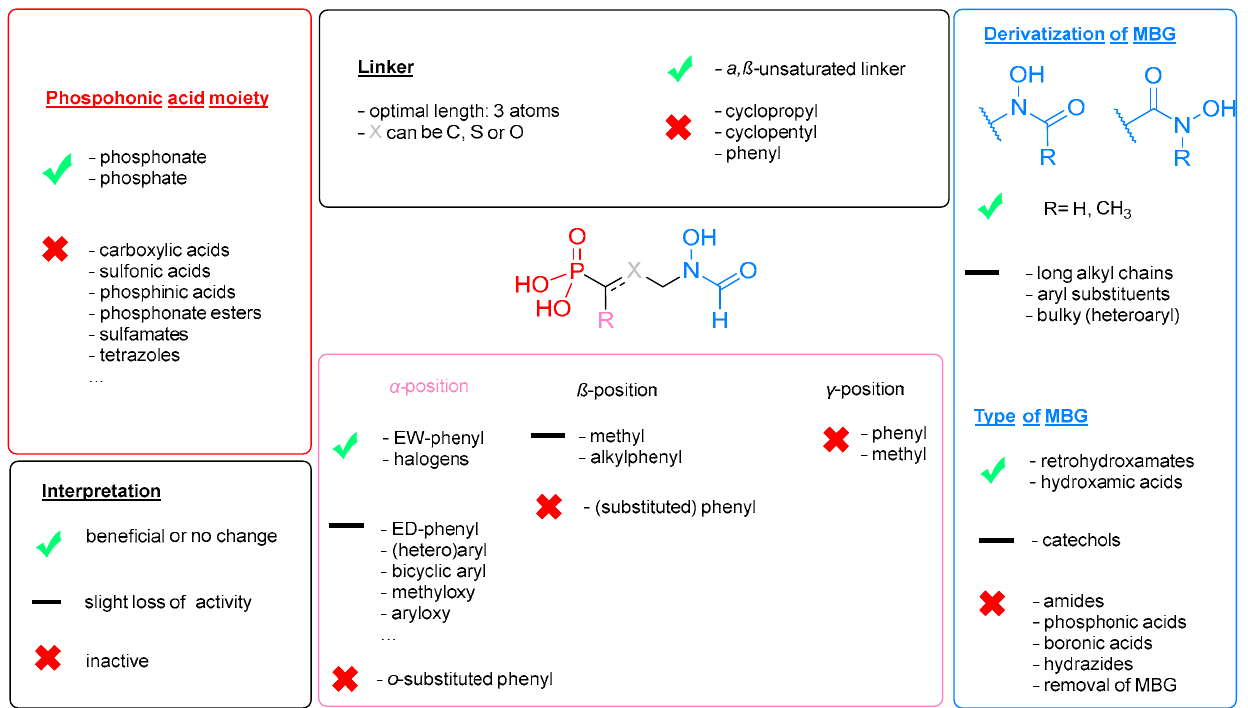
Figure 29. Structure–activity relationship (SAR) of fosmidomycin derivatives. EW = electron withdrawing, ED = electron donating, o = ortho, MBG = metal binding group.